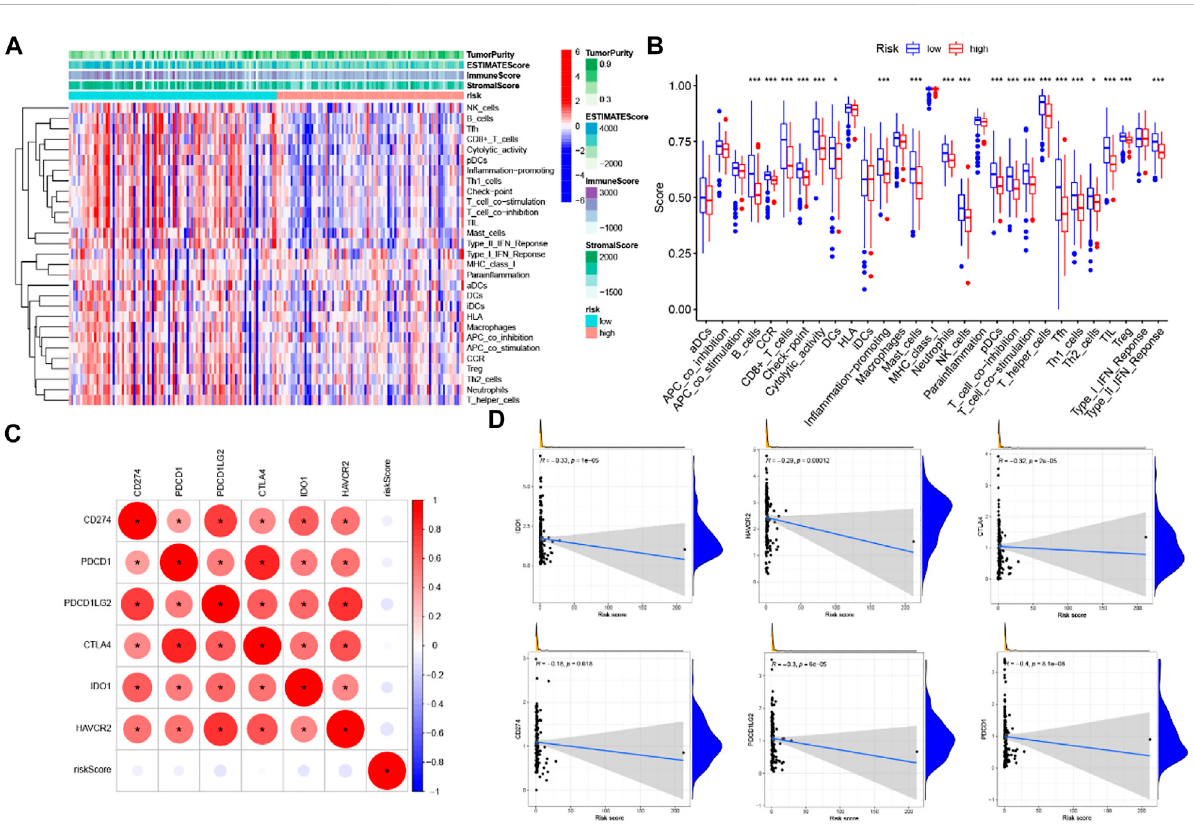
FIGURE 12 Correlation of prognostic risk score with TIME characterization (A) immune-related signature with corresponding immune-related scores in groups low/high risk. (B) A distinction of enrichment of immune-related signatures between low-/high-risk groups. (C) Association analyses between immune checkpoint inhibitors and GILncSig. (D) Association between risk model and CD274, CTLA4, HAVCR2, PDCD1,